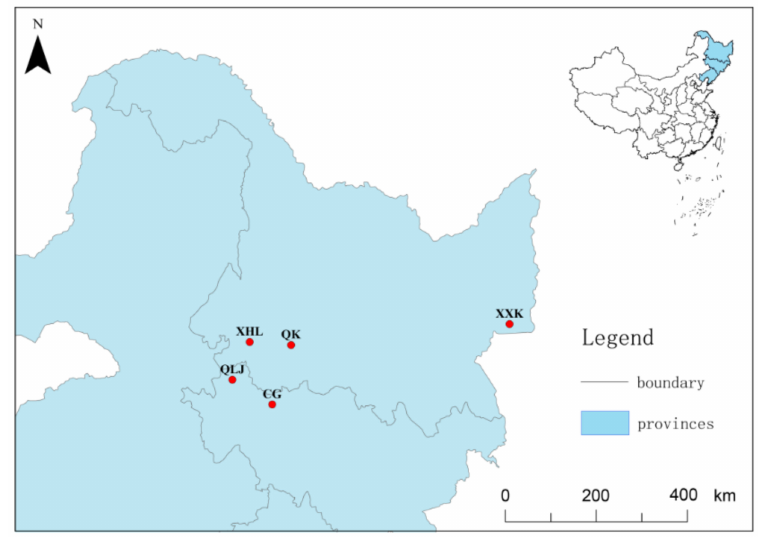
Figure 1. Geographical location and abbreviation of five freshwater lakes. Lakes shown are Xiaox- ingkai (XXK), Qingken (QK), Xihulu (XHL), Qianliujia (QLJ), and Chagan